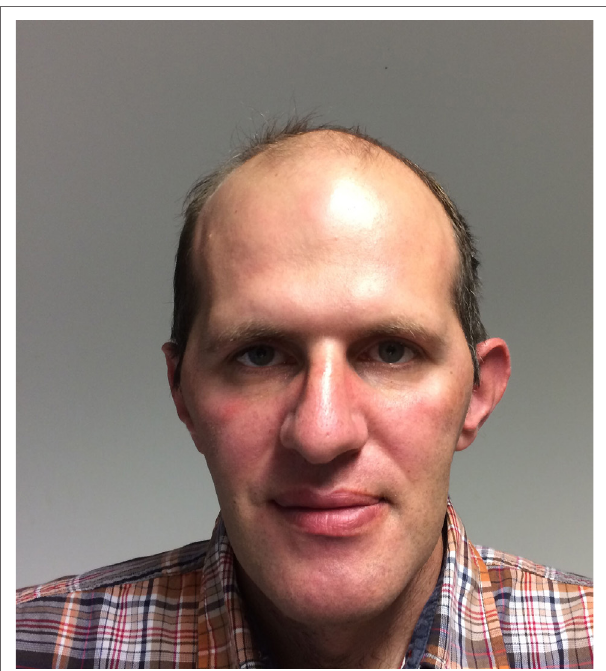
FiGURe 2 | The characteristic face of a patient with DM1: long face, temporomandibular wasting, balding